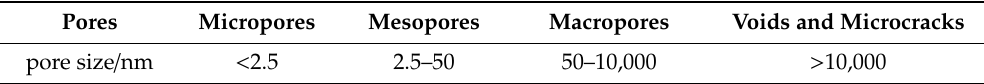
Figure 5. Pore size distribution of cement specimens.